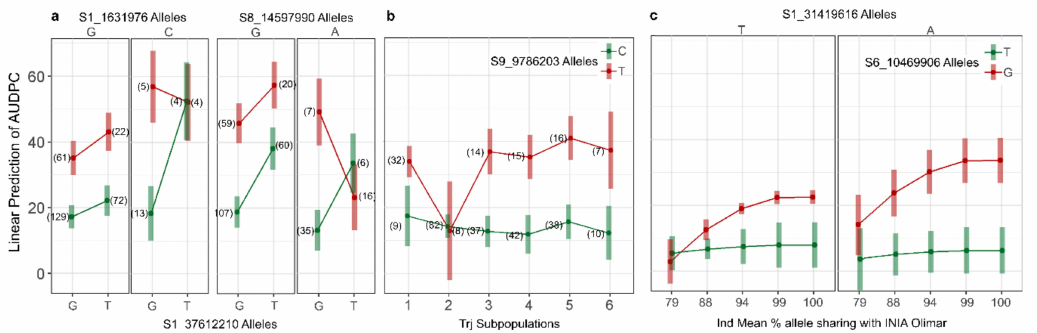
Figure 5. Quantitative trait locus (QTL) by QTL and QTL by genetic background interactions in tropical japonica and indica subpopulations. ( a ) Triple QTL interactions among tropical japonica blast resistance loci S9_9786203 by S1_37612210 by S1_1631976 and S9_9786203 by S1_37612210 by S8_14597990. The e ff ect of the favorable allele S9_9786203:C (in strong linkage disequilibrium with the blast resistance gene cluster Pii / Pi3 / Pi ), changed from resistance to susceptibility in genotypes that combine the S1_37612210:T and S1_1631976:C alleles, or from resistance to intermediate resistance in genotypes combining the S1_37612210:T and S8_14597990:A alleles. ( b ) QTL by genetic background interaction in the tropical japonica subpopulation (Trj), with genetic background modeled as pedigree-based groups 1 to 6. The e ff ect of the susceptible allele S9_9786203:T was not significantly di ff erent to that of the resistance allele S9_9786203:C in genotypes belonging to group 2. For ( a , b ) the number of genotypes with each allelic combinations is shown in curved brackets ( c ). QTL by QTL and QTL by genetic background interactions in the indica subpopulation (Ind). As the proportion of shared alleles with the susceptible indica cultivar INIA Olimar increases, so does the area under disease progress curve (AUDPC) of genotypes with the susceptible allele S6_10469906:T. This increment in susceptibility is less pronounced when the S4_31419616:T favorable allele is present. Error bars show the 95% confidence intervals for the estimated marginal means of